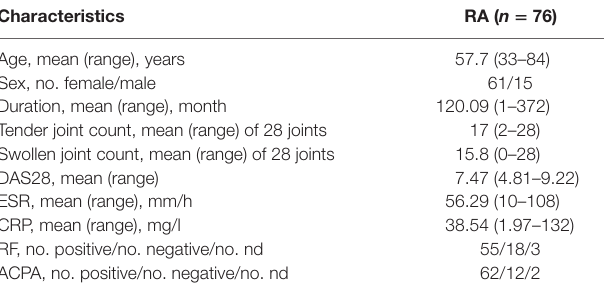
TaBle 1 | Clinical characteristics of RA patients.